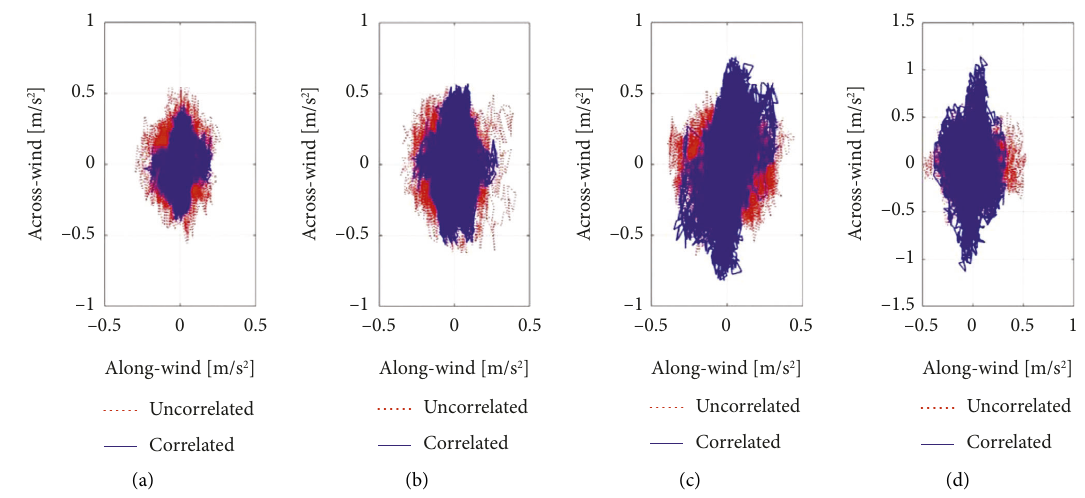
Figure 23: Rooftop accelerations of the shear buildings in time domain. (a) H/ √ BD � 2, (b) H/ √ BD � 4. (c) H/ √ BD � 6. (d) H/ √ BD � 8.